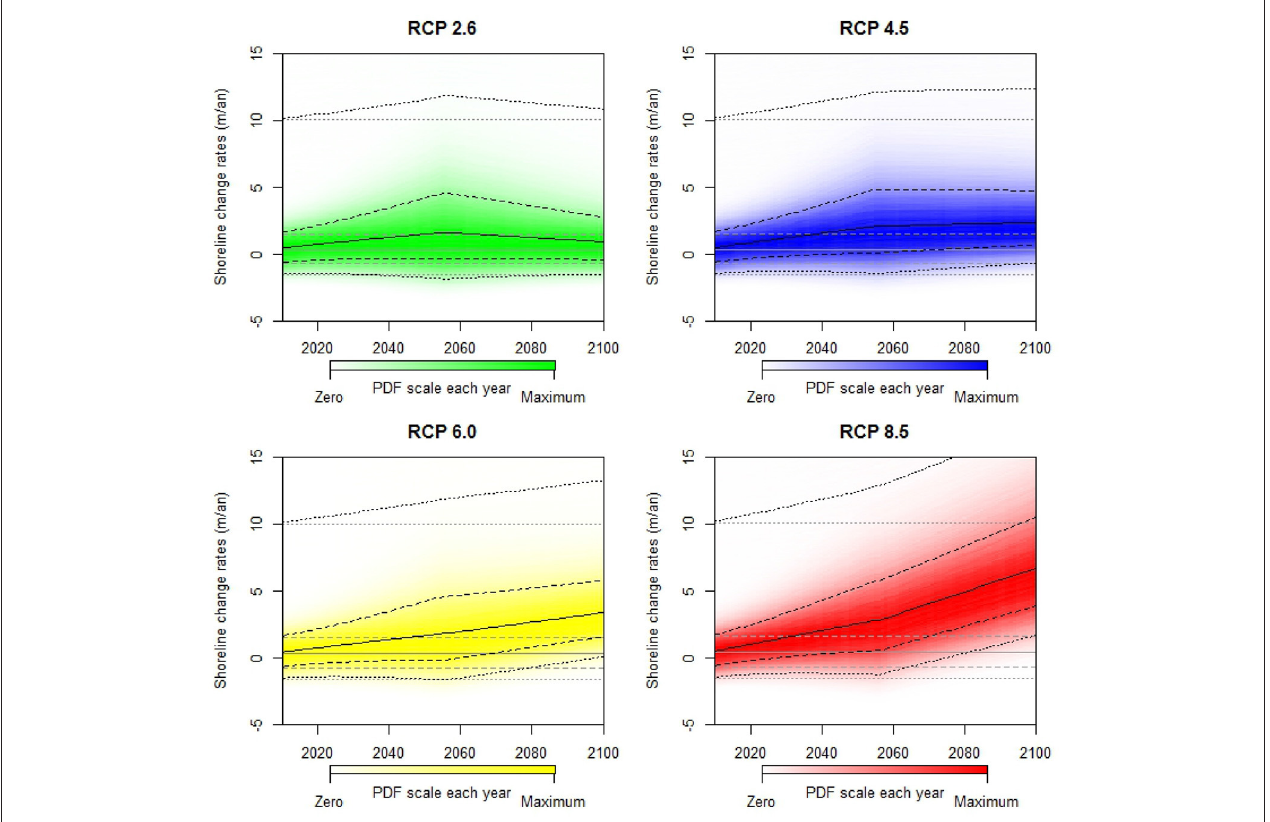
FIGURE 5 | Shoreline change rate projections for the 21st century for low-energy sandy coasts with no impacts of man-made infrastructures and for different IPCC climate change scenarios. The meaning of gray and black lines is the same as in Figure 3 .